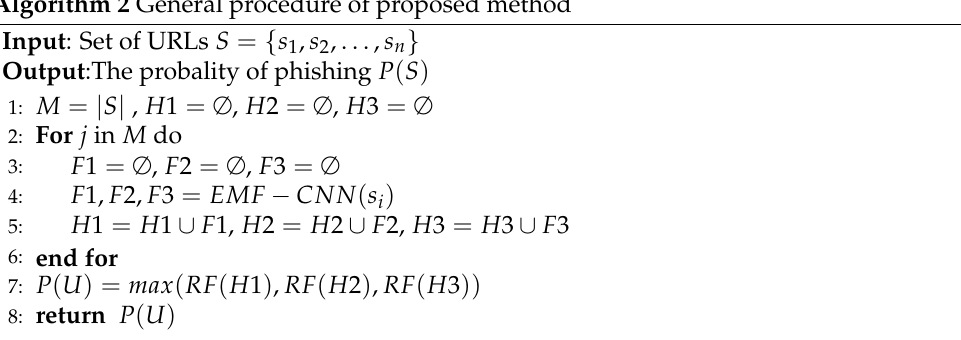
Algorithm 2 General procedure of proposed